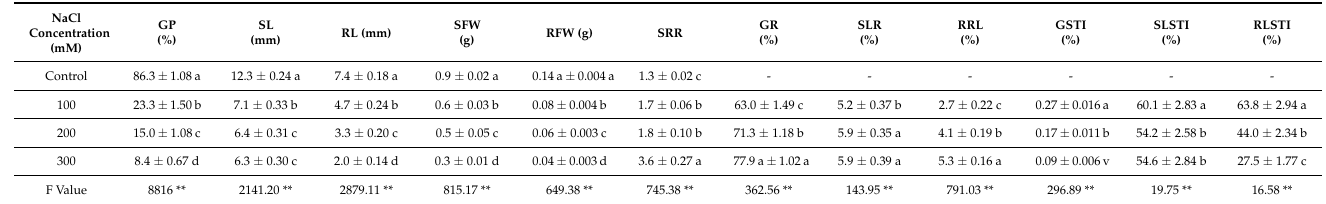
Table 2. Mean effect of the salt stress level (0, 100, 200 and 300 mM NaCl) on germination potential and seedlings characteristics (mean ± SD), regardless of the squash